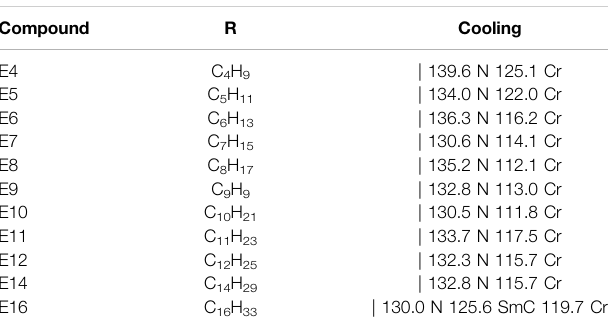
TABLE 1| PhaseTransitiontemperatures( ° C)ofthementioned compounds while cooling. Compound